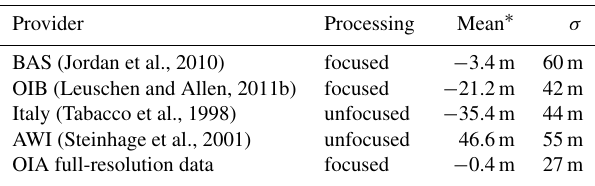
Table 2. Bed elevation data set comparison to an OIA focused data grid, with mean offset and standard deviation σ of bed elevation